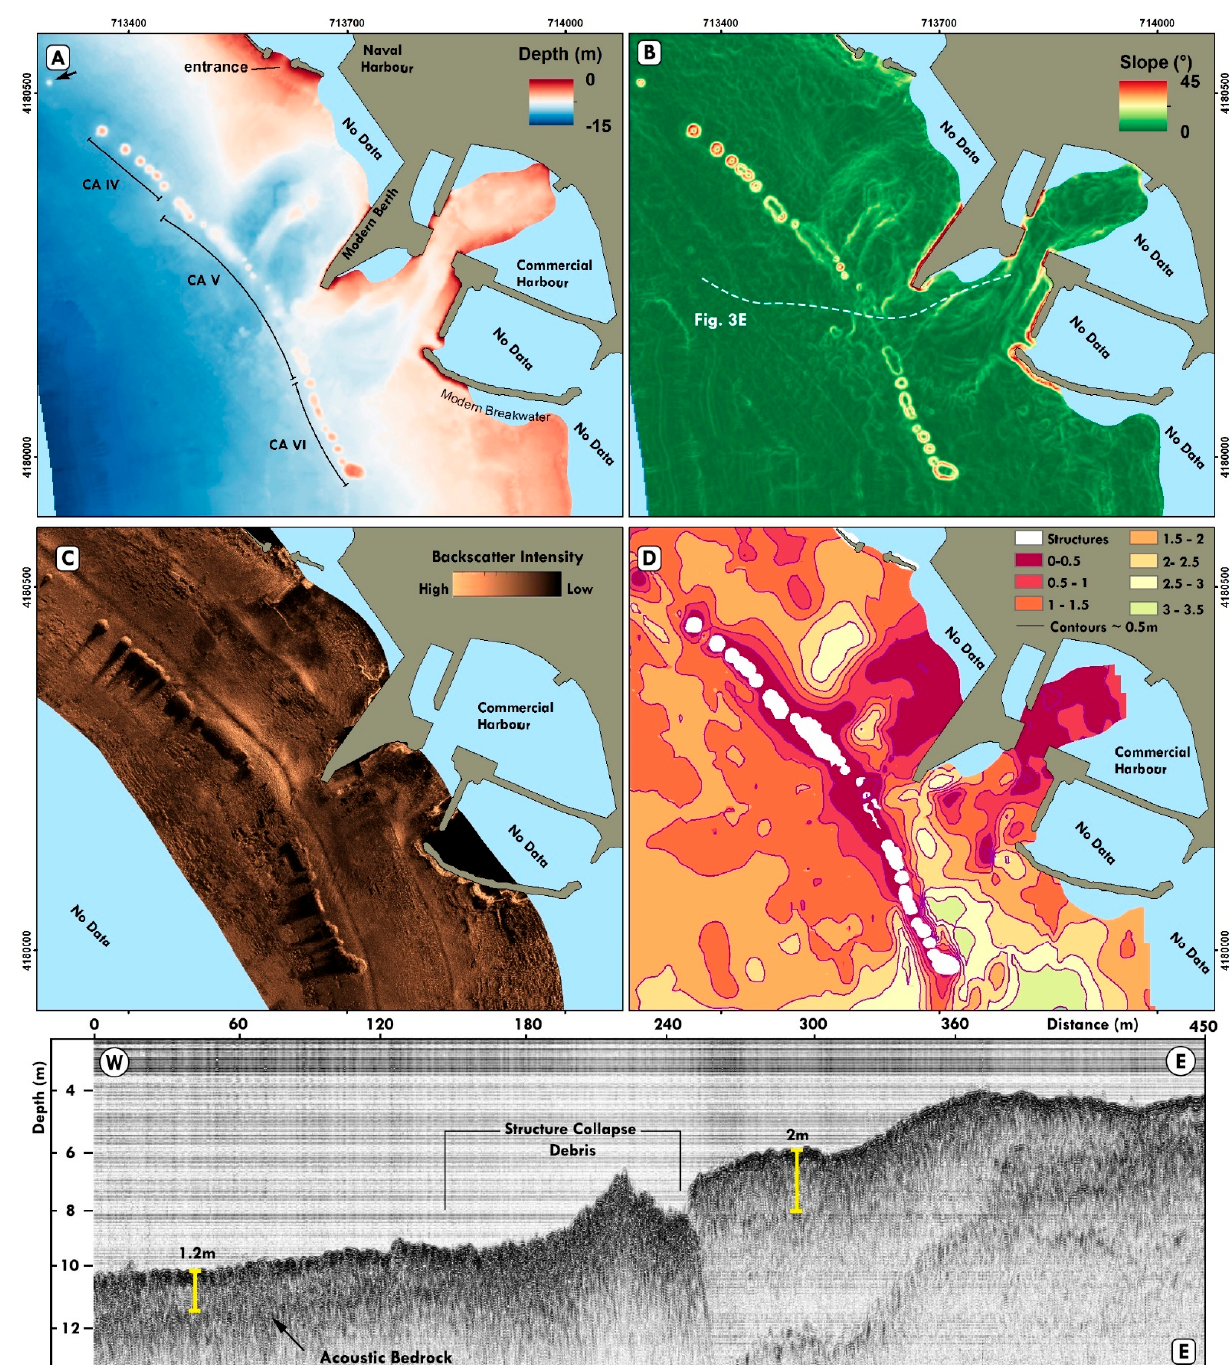
Figure 4. Geophysical data from the central area (ii) as delimited in Figure 1. ( A ) bathymetric map, ( B ) slope map, ( C ) backscatter intensity map, ( D ) sediment thickness map, ( E ) seismic profile (location is shown in Figure 4C).